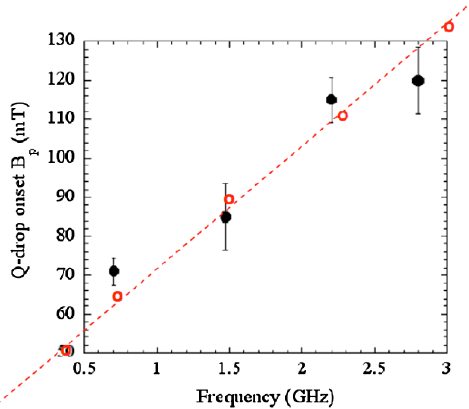
FIG. 6. Q drop onset field measured at different frequencies. The data point at 2.82 GHz was measured in the TE 011 mode (from Ref.